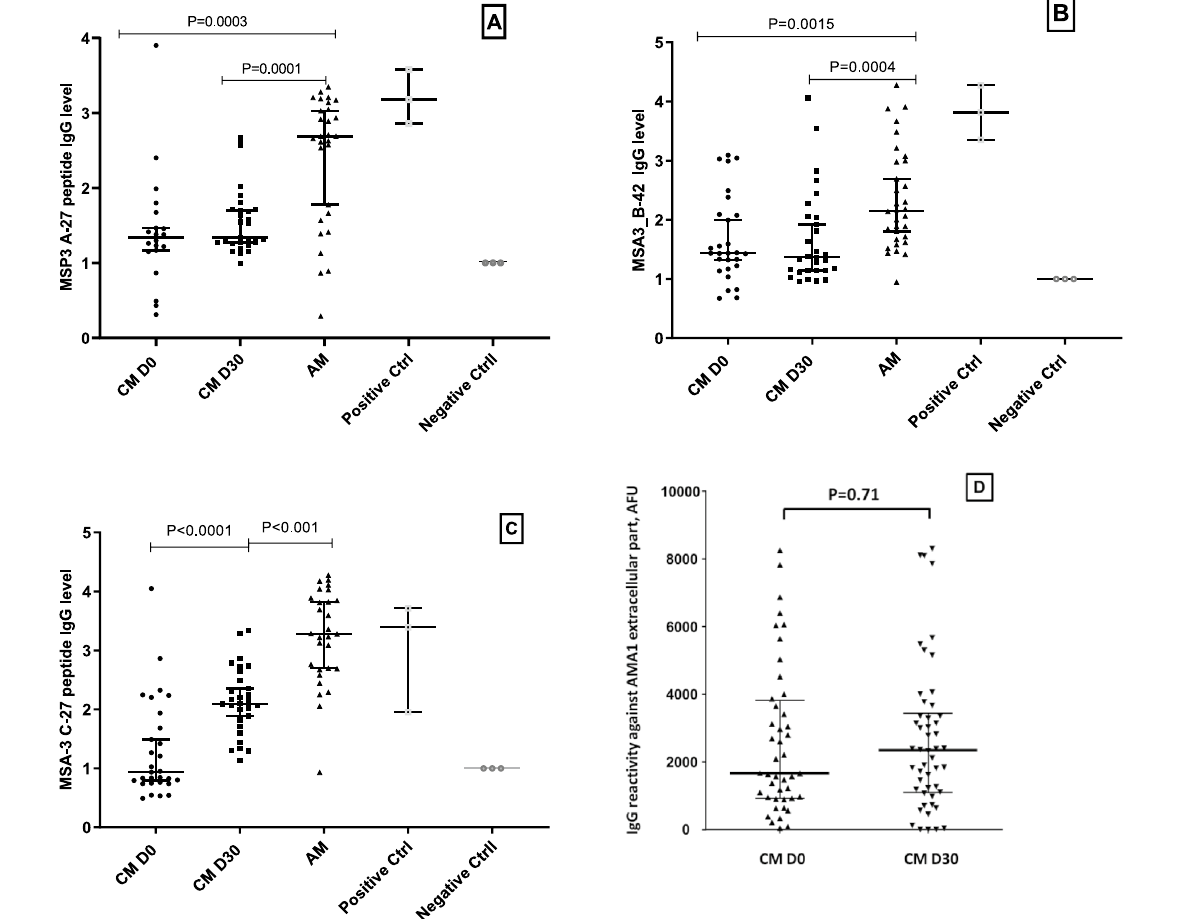
Figure 4. IgG response against MSA3 A-27 ( A ), MSA3 B-42 ( B ), MSA3 C-27 ( C ) peptides and against extracellular part of AMA-1 antigen ( D ) in children with CM at Day 0 and Day 30. Data for parts A , B , and C were obtained by ELISA. Day 0—black circles, Day 30—black squares, AM children black triangles. Empty squares are the positive control and empty circles are the negative control. Data for part D was obtained using BioPlex bead-immobilized construct. P value by Mann–Whitney